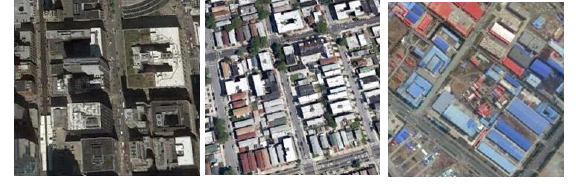
Figure 1. Sample classes of urban area in remote sensing images (a) commercial building (b) residential area and (c) industrial